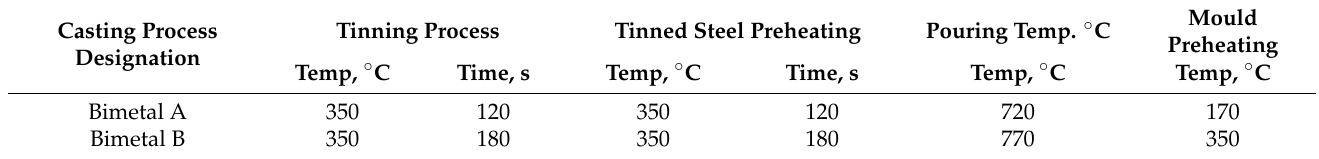
Table 2. Process parameters for two different bimetal castings groups.